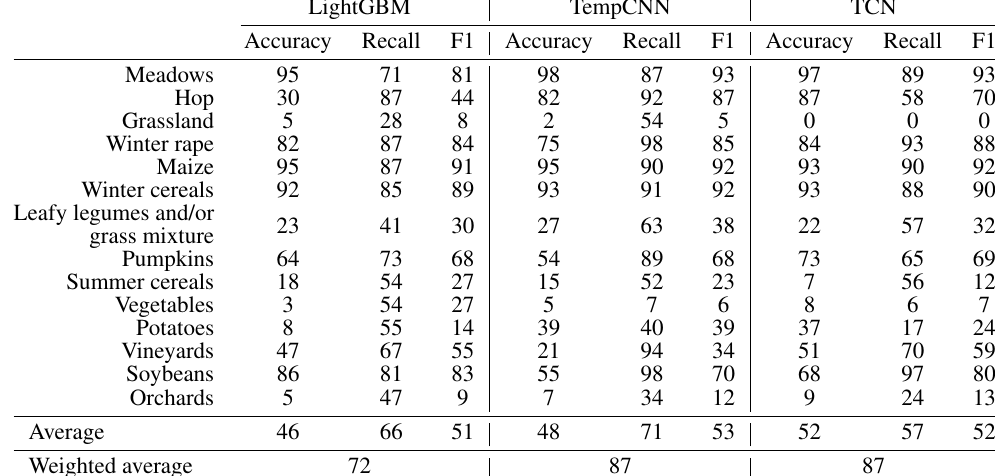
Table 2. Classification score per crop type.